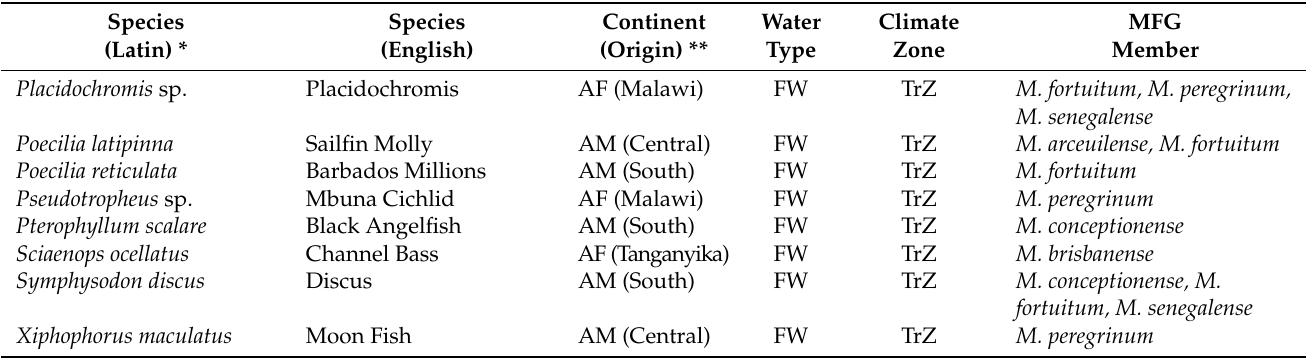
Table interpretation. * In alphabetical order; ** Original occurrence of the fish species; *** Sea of temperate and subtropical belt; AF = Africa; AS = Asia; AO and MS = Atlantic Ocean and Mediterranean Sea; AM = America; MFG = Mycobacterium fortuitum Group; FW = Freshwater; SW = Saltwater; TeZ = Temperate Zone; TrZ = Tropical Zone; M. = Mycobacterium